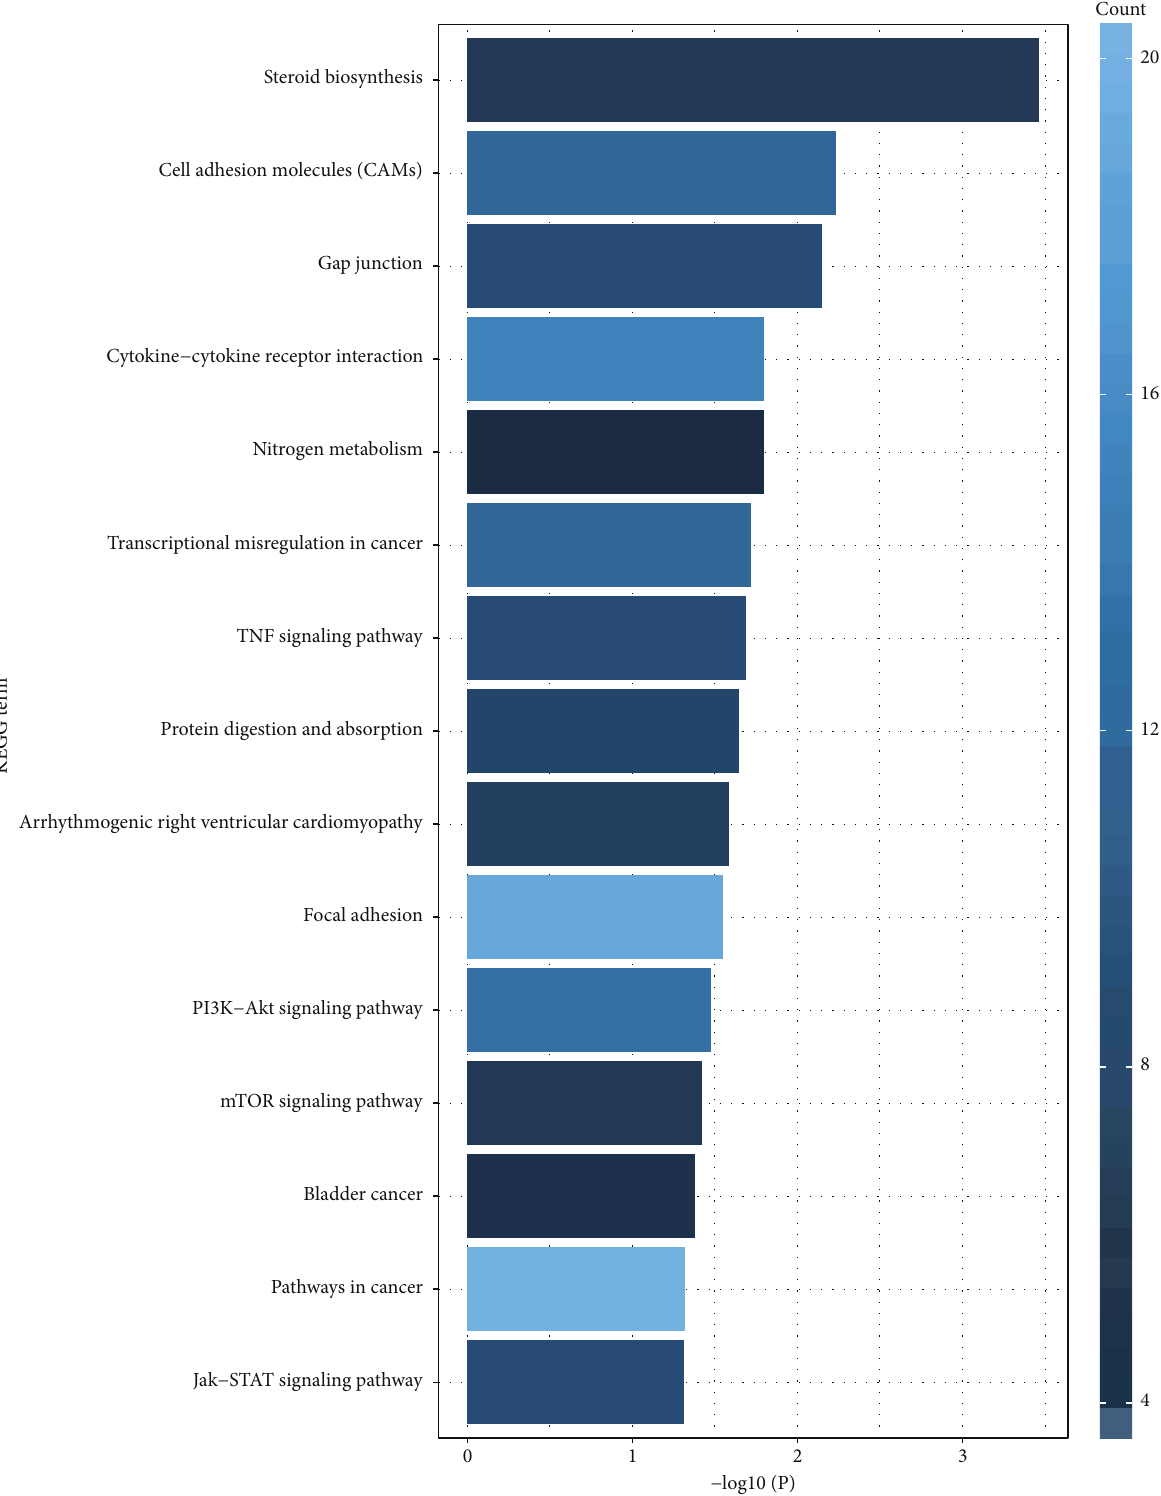
Figure 4: Top fi fteen signi fi cant pathways associated with the DEGs according to P value in KEGG analysis. KEGG: Kyoto Encyclopedia of Genes and Genomes; DEGs: di ff erentially expressed